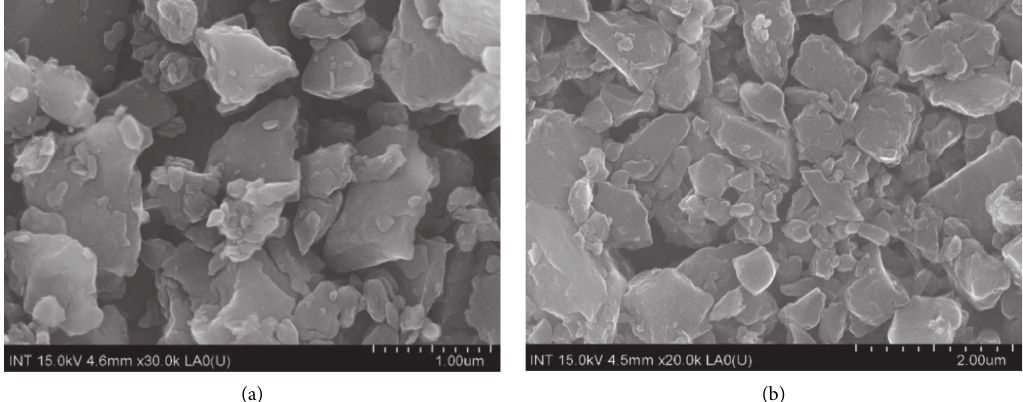
Figure 4: SEM images of AC powder (a) and AC-based electrode (b).